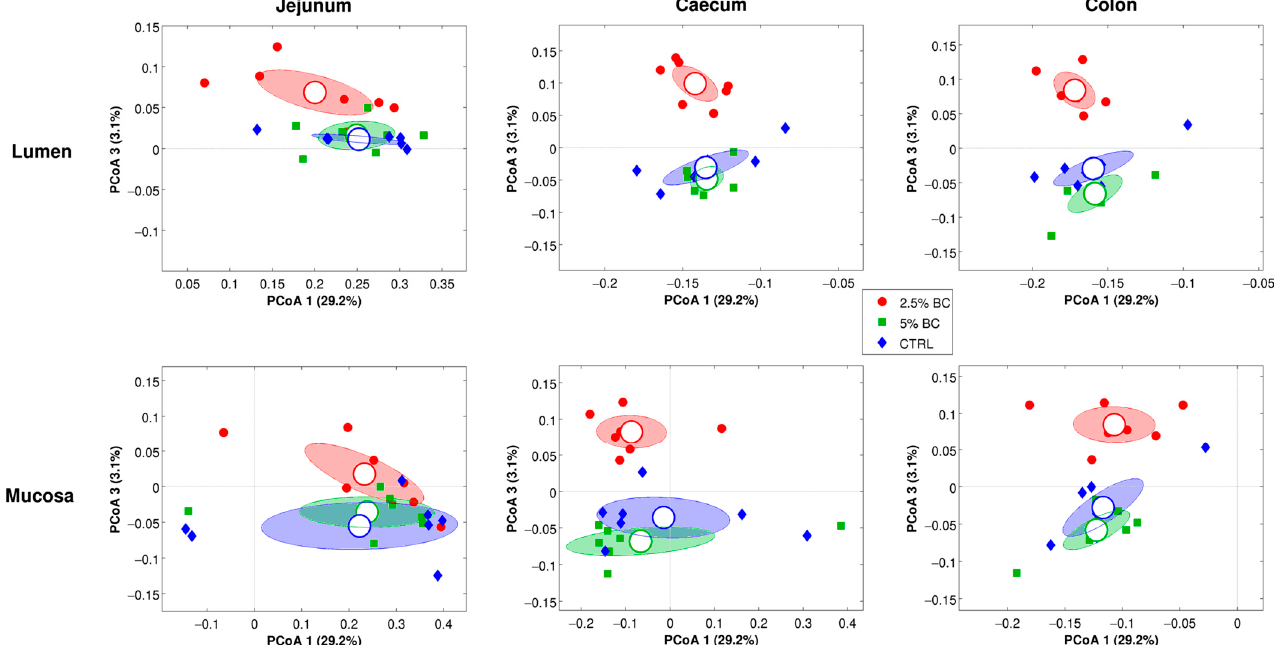
Figure 3. Principal Coordinate Analysis (PCoA) based on the unweighted UniFrac distances for the three diet groups divided per intestinal tract and site. In each plot, each dot represents a sample, colored according to the diet group. Ellipses are the 95% SEM-based confidence intervals, whereas centroids are the average coordinates on all the samples. Coordinates 1 and 3 are represented.